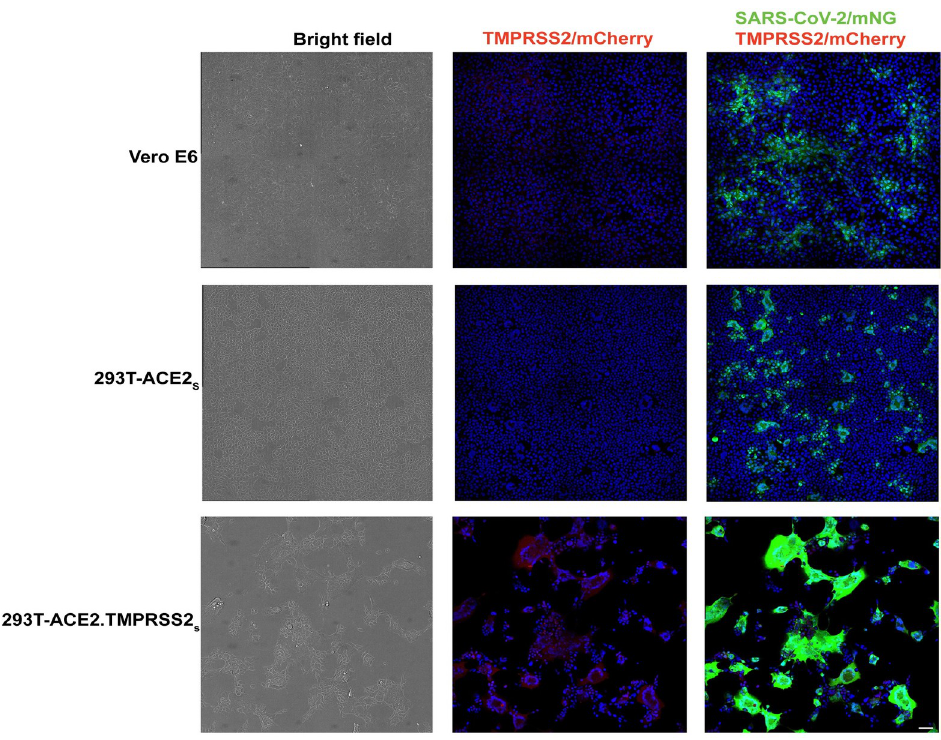
Fig 2. Infection of Vero E6, 293T-ACE2 s and 293T-ACE2.TMPRSS2 s with replicating SARS-CoV-2-mNG virus. Cells inoculated with 100 PFU/ml of virus (MOI 0.1) were fixed and imaged at 24 hours post infection by confocal microscopy. The left column shows bright field images (black and white), with the 293-ACE2.TMPRSS2 cells (bottom) showing a high degree of cytopathic effect and syncytium formation, resulting in fewer cells. The center column shows merged images of TMPRSS2/mCherry and Hoechst dye (blue) with only the 293-ACE2.TMPRSS2 cells (bottom) showing positive signals in red. The right column shows merged images of SARS-CoV-2/mNG (green), TMPRSS2/ mCherry (red), and Hoechst dye (blue). Compared to Vero (top) and 293-ACE2 (middle), the 293T-ACE2.TMPRSS2 (bottom) cells show stronger SARS-CoV-2 nNG signals in green. Scale indicates 50um.